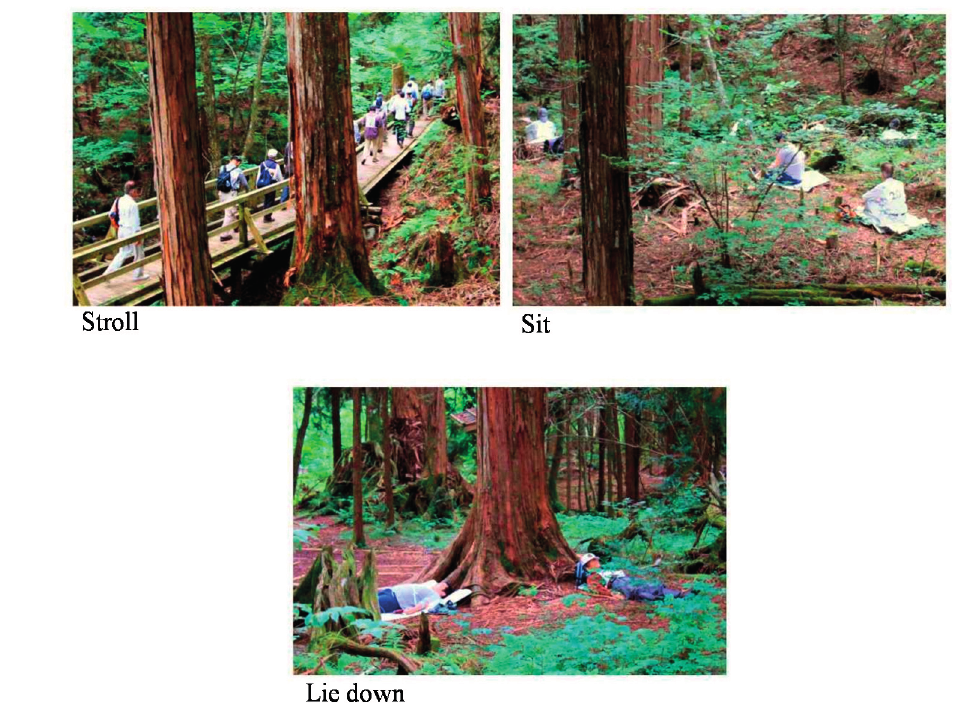
Figure 1. Images of the forest therapy